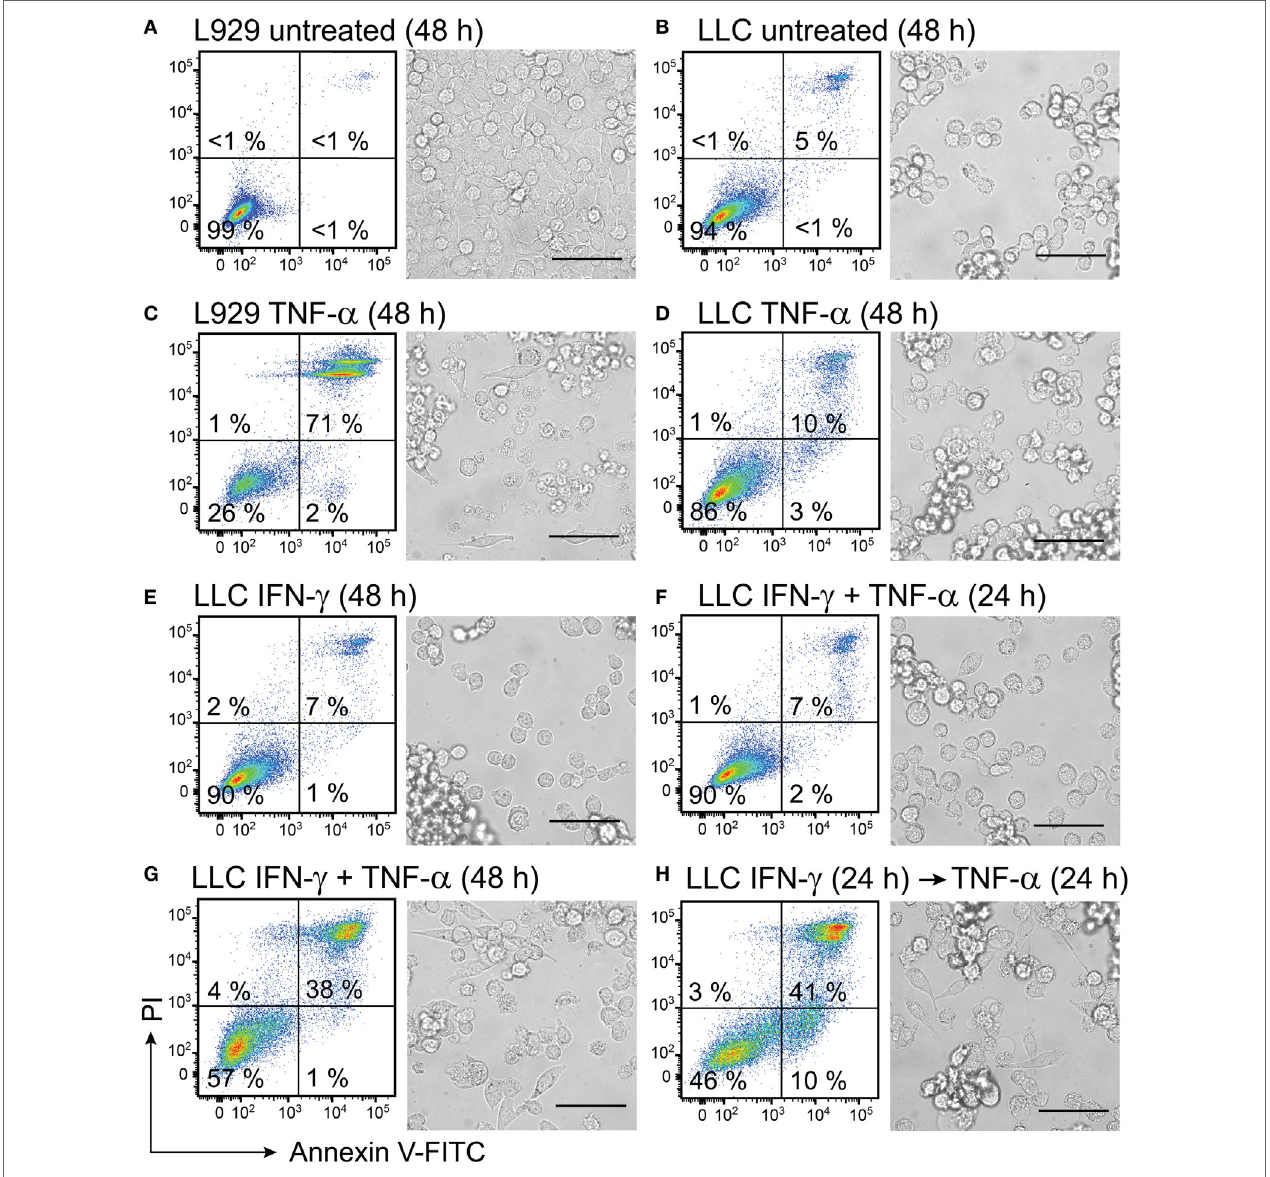
FigUre 8 | Interferon (IFN)- γ in combination with TNF- α induces cell death in mouse lung carcinoma cells. L929 fibroblasts and Lewis lung carcinoma (LLC) cancer cells were cultured for 24 h before starting treatment with recombinant cytokines. Both L929 and LLC cells were (a,B) left untreated for 48 h and used as negative controls or (c) L929 cells were treated with 50 ng/mL TNF- α for 48 h and used as a positive control. LLC cell viability was retained after treatment with (D) 50 ng/mL TNF- α or (e) 100 ng/mL IFN- γ and after (F) simultaneous treatment with both 50 ng/mL TNF- α and 100 ng/mL IFN- γ for 24 h. Cell death was induced in LLC cells after (g) simultaneous treatment with 100 ng/mL of IFN- γ in combination with 50 ng/mL of TNF- α for 48 h and after (h) LLC pretreatment with 100 ng/mL of IFN- γ for 24 h followed by treatment with TNF- α for 24 h. The resulting cell monolayers were analyzed using bright-field microscopy (scale bar, 50 µM). Cell death was determined using flow cytometry analysis after cell staining with annexin V-FITC (depicted on the x -axis) and propidium iodide (PI, depicted on the y -axis). Annexin V-positive/PI-negative cells were regarded as apoptotic, whereas annexin V-positive/PI-positive cells were regarded as necrotic. Experiment was performed in duplicates and repeated two times with standard error not exceeding 10% between independent experiments. One representative experiment is shown, where the percentages of the four distinct cell populations are averages of duplicates with SEM <